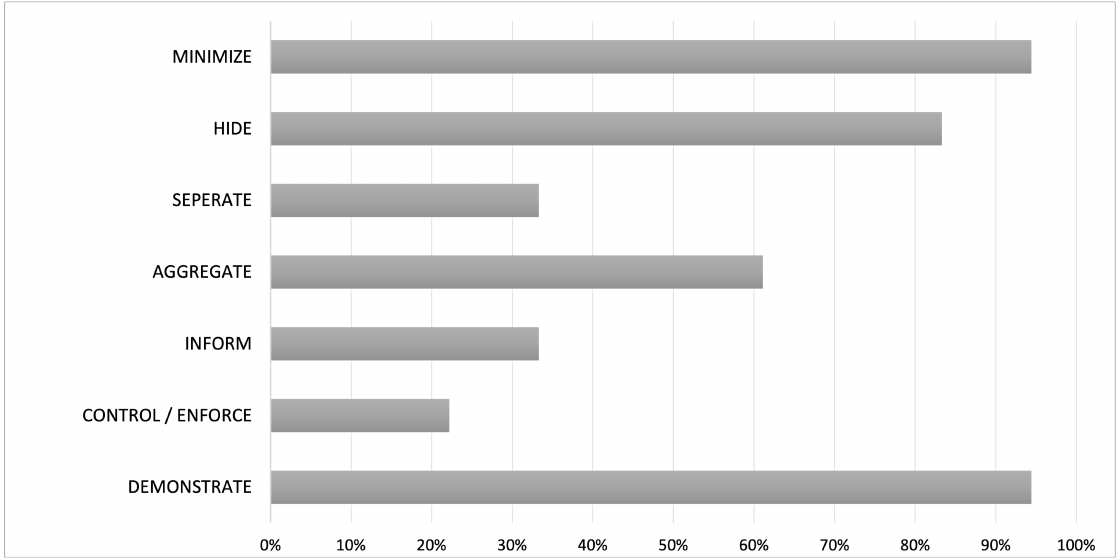
Figure 4. Strategies from [36], which were implemented most frequently in the analyzed articles (in